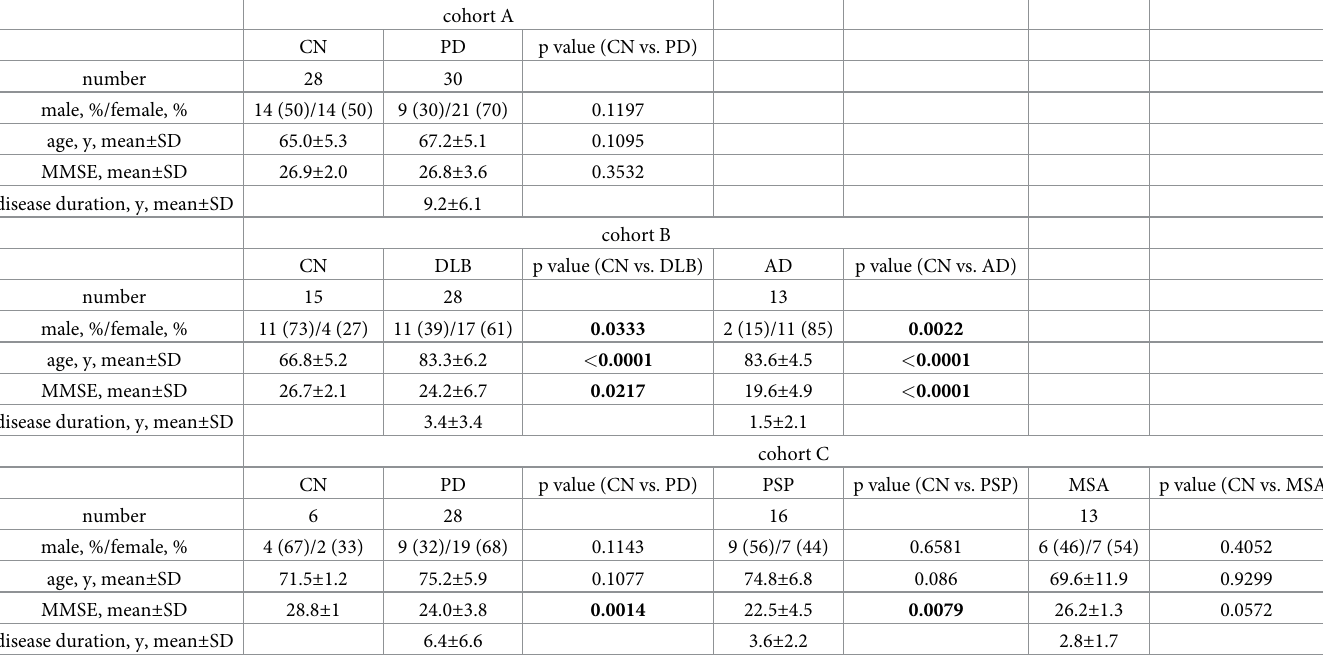
Table 1. Demographics and clinical characteristics of the analyzed plasma samples in Cohorts A, B and C. cohort